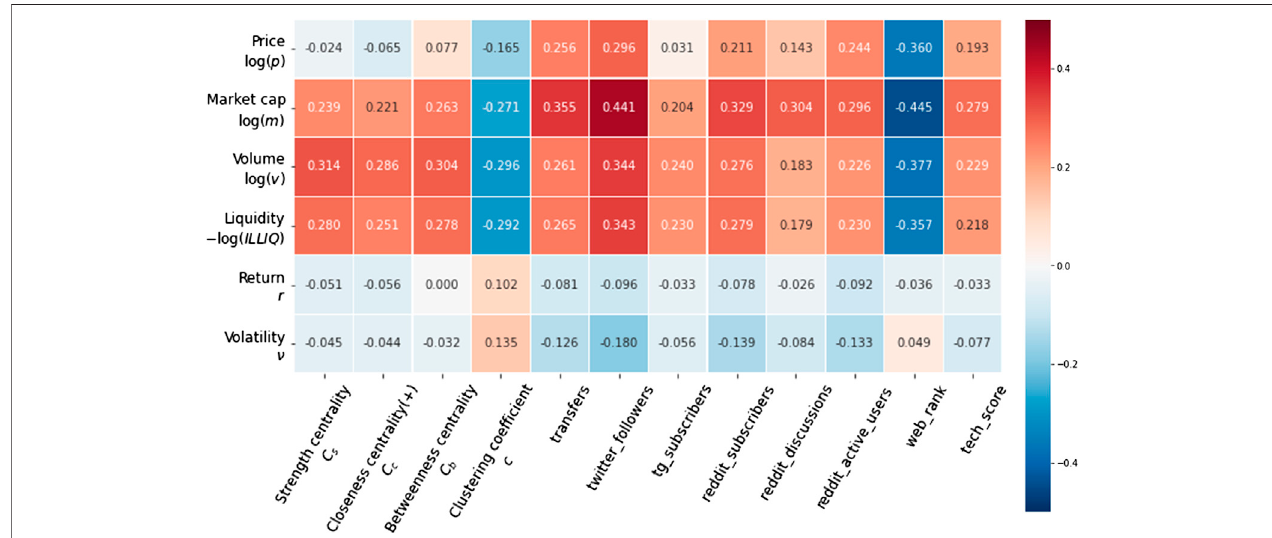
FIGURE 3 | Correlation heat map between the market indicators and the market embeddedness and control variables.